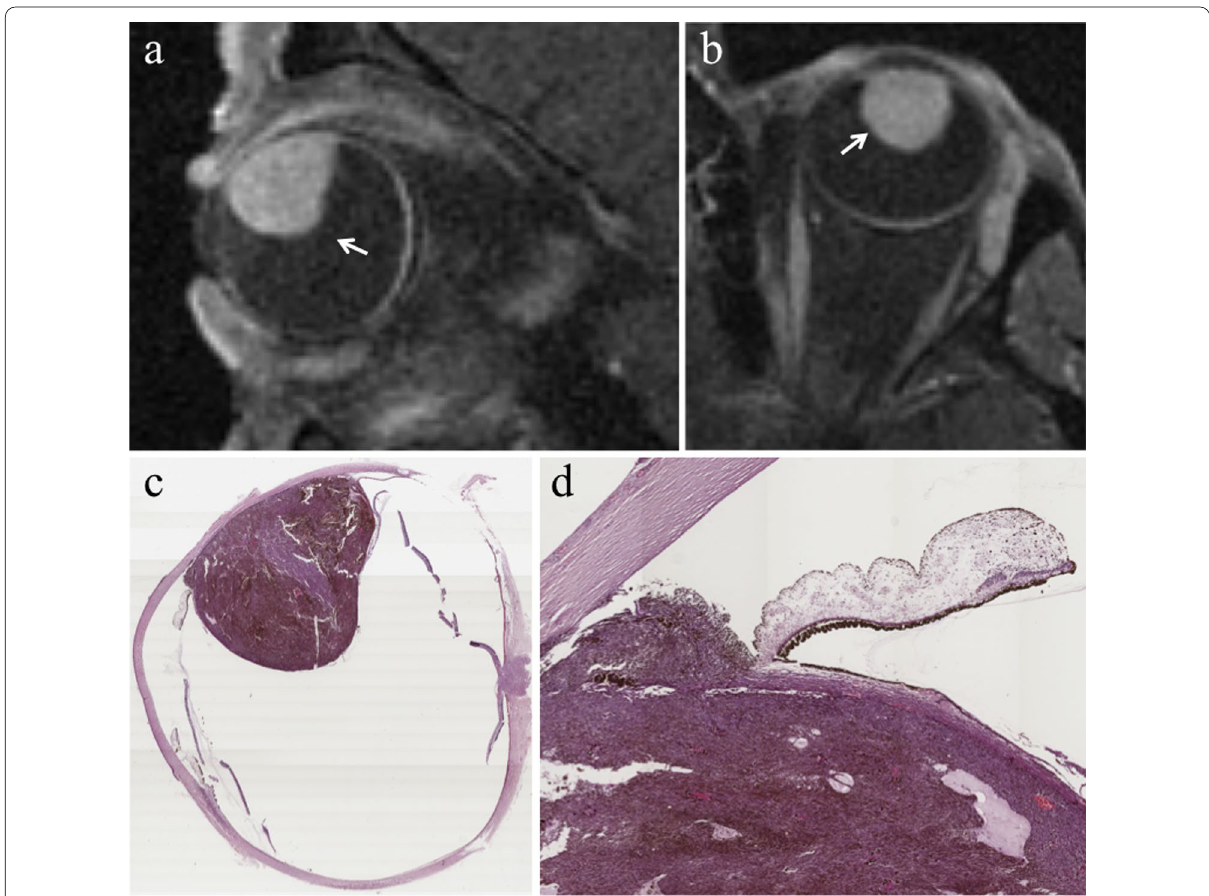
Fig. 2 A 40-year-old man with a ciliary body melanoma of the left eye. The same patient as in Fig. 1. ( a ) Sagittal and ( b ) axial contrast-enhanced fat-suppressed T1-weighted images illustrate a homogeneously enhancing intraocular lesion along the antero-superior aspect of the globe (white arrows), with ciliary body invasion. c On low magnification histological examination shows a strong overlap with MR imaging: a pigmented mass that protrudes into the posterior segment of the eye is clearly identifiable (H&E, original magnification 25). ( d ) Higher magnification showing the × initial invasion of the ciliary body by melanoma cells (H&E, original magnification ×